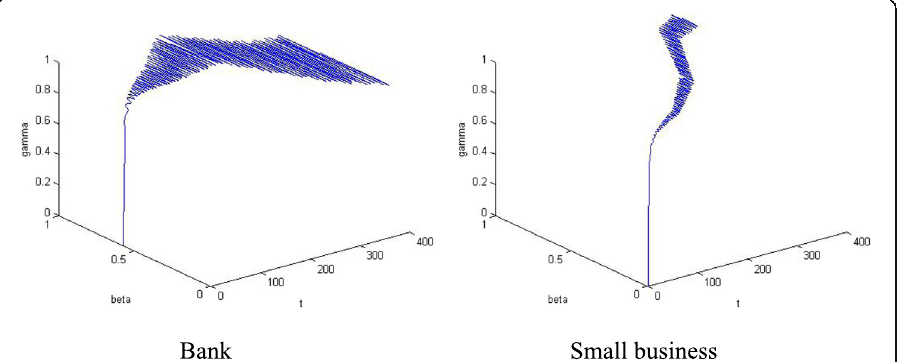
Fig. 4 Trust evolution in the case of (T, R-T, D). Note: (T, R-T, D) refers to the situation that the strategy portfolio changes from (T, R) during the period of [0, t d ] to (T, D) during the period of [ t d , t ]. Namely, bank decides to trust a small business (T), and small business respects the loan contract (R) during the first rounds ([0, t d ]) and then the small business starts to default (D) after t d . We use the standardized data to generate the simulation results in order to be consistent in